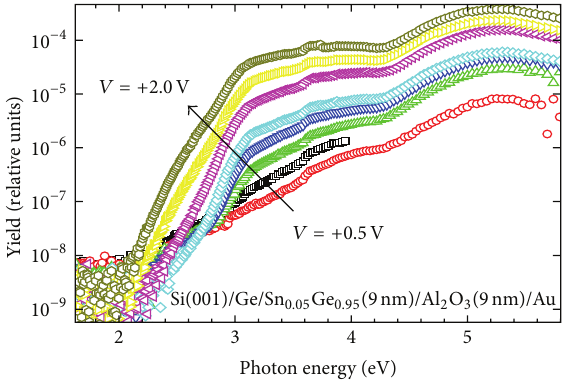
Figure 22: Semilogarithmic plot of the IPE quantum yield as a function of photon energy as measured on (100)Si/Ge/Sn 0.05 Ge 0.95 (9 nm)/Al 2 O 3 (9 nm)/Au sample with the applied bias varying from 0.5 V to 2.0